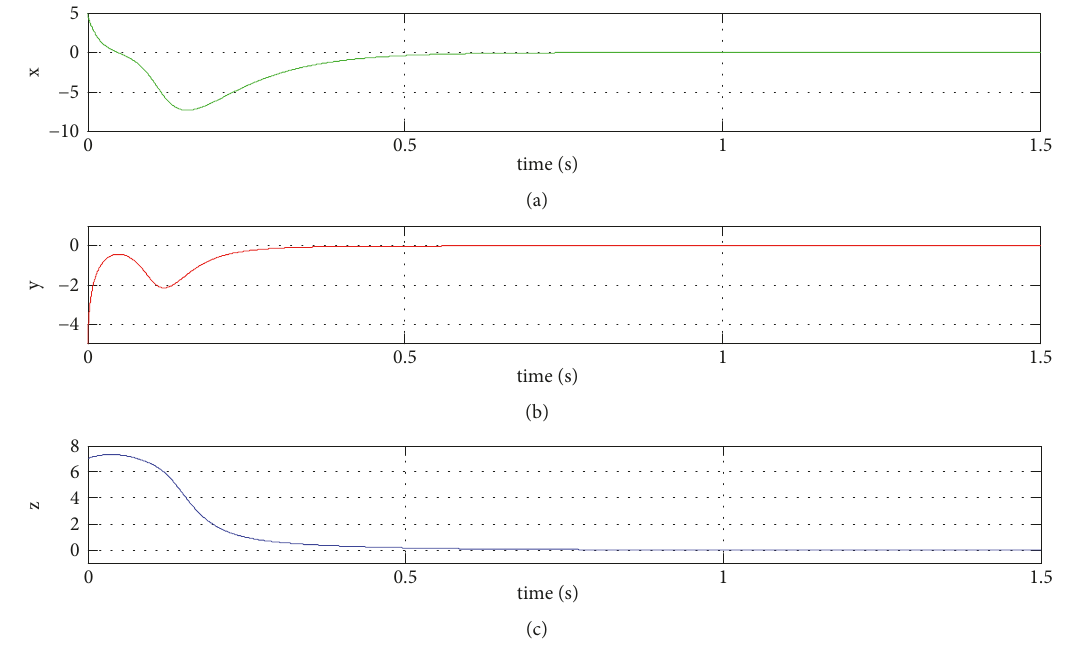
Figure 2: Adaptive stabilization for (a) state 𝑥 , (b) state 𝑦 , and (c) state 𝑧.